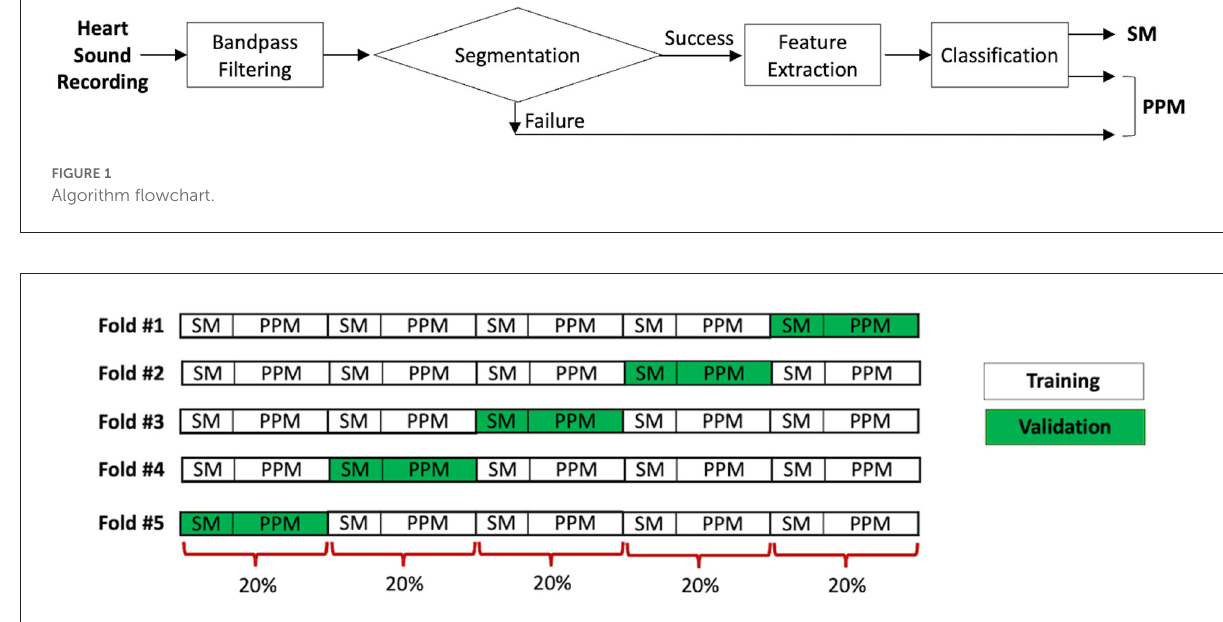
FIGURE2 Schematic showing formation of training and validation sets for 5-fold cross